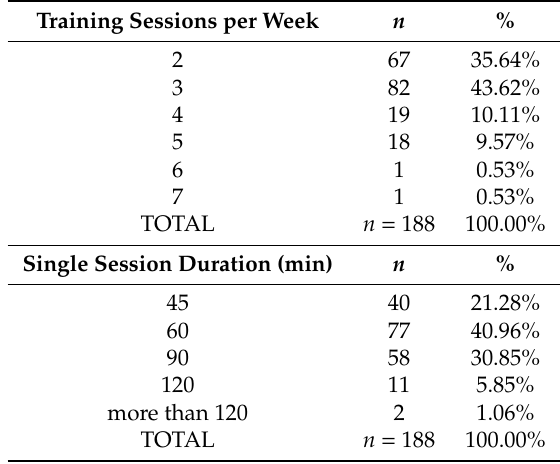
Table 2. Training sessions per week and single session durations (in minutes) among active